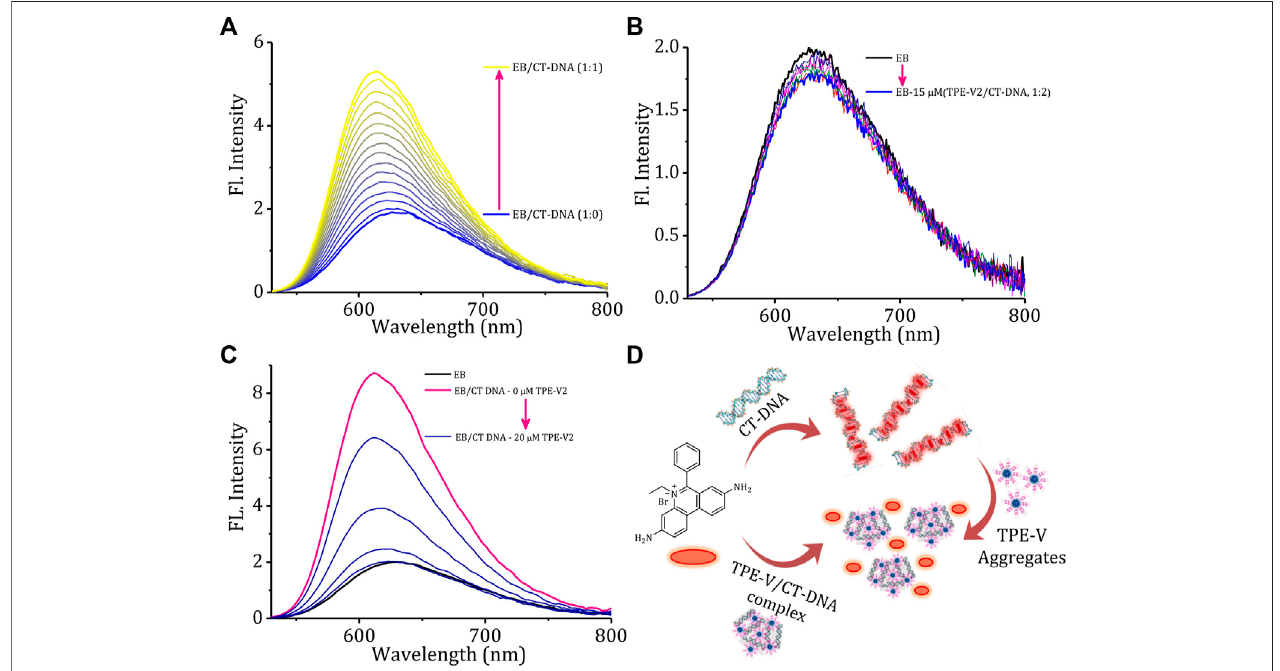
FIGURE 3 | Changes in the emission spectra of EB (15 μ M) with increasing concentrations of (A) CT-DNA (0 – 15 μ M) and (B) TPE-V2/CT-DNA (1:2 complex, 0 – 15 μ M). (C) Changes in the emission spectra ofEB/CT-DNA complex (1:2) with the sequential addition of TPE-V2 (0 – 20 μ M) and (D) schematic representation of the overall EB intercalation and displacement